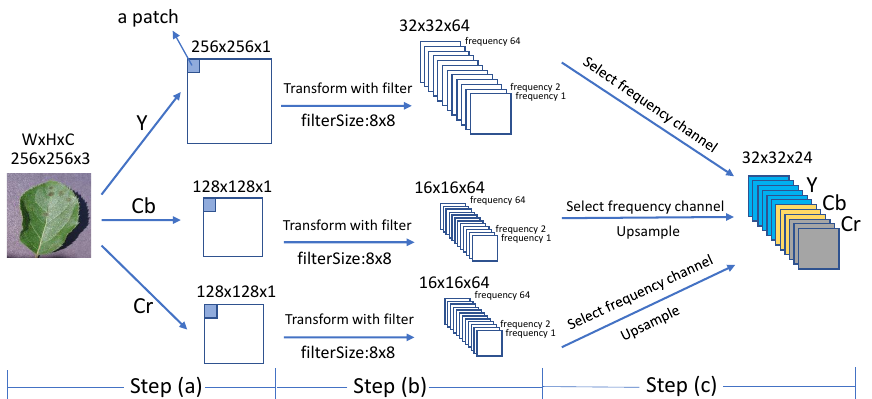
Figure 8. The pipeline of the DCT module. Step (a): The 2D RGB image is transformed to three channels: Y, Cb and Cr. Then, the channels are separated into patches as the size S DCT × S DCT . Step (b): The Y, Cb and Cr channels are filtered by different frequent filters and reshaped to frequency cube. In the cube, each channel represents each frequency. Step (c): Informative frequency channels are selected to be frequency representations of the